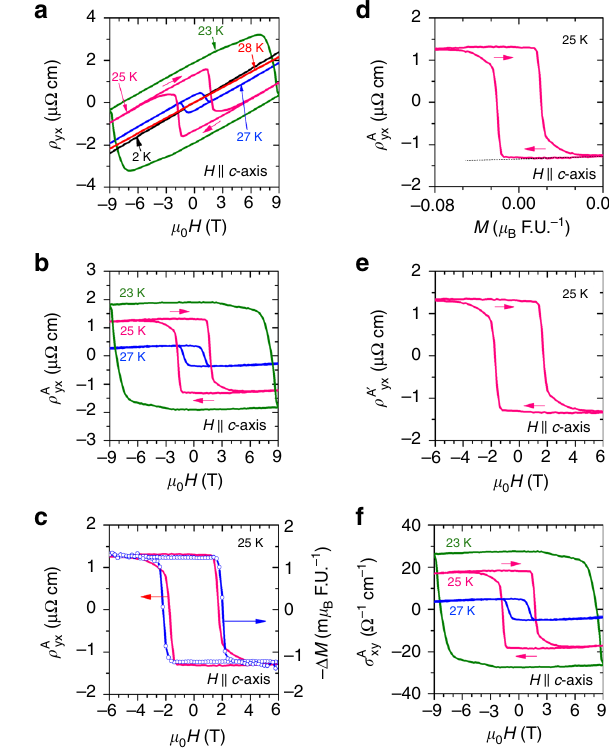
Fig. 3 Hall effect in CoNb 3 S 6 with magnetic fi eld along c -axis. a Hall resistivity as a function of magnetic fi eld. b Anomalous Hall resistivity as a function of magnetic fi eld obtained by subtracting the ordinary Hall resistivity ρ yx as discussed in the text. c Scaling of the Hall resistivity and the ferromagnetic moment. d Anomalous Hall resistivity as a function of magnetization. The straight line represents the slope of the high fi eld ρ A M that gives the anomalous Hall part due to the ferromagnetic component from the fi eld-induced spin tilt. e Anomalous Hall resistivity obtained by subtracting the estimated Hall contribution form the ferromagnetic component of magnetic fi eld-induced spin tilt as a function of magnetic fi eld. f Hall conductivity as a function of magnetic fi